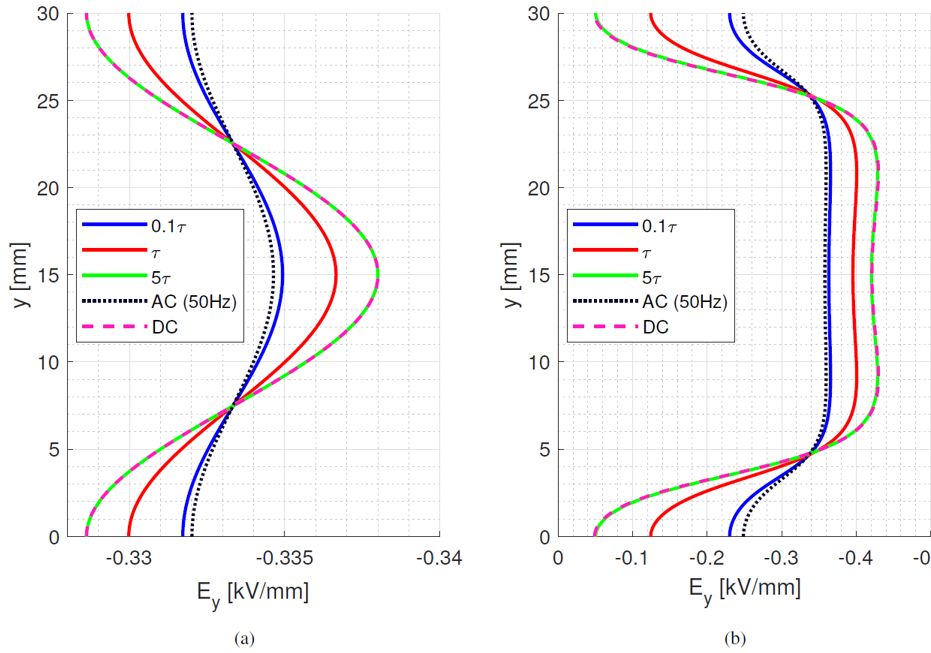
Figure 5. ( a ) bulk orthogonal and ( b ) surface tangential field at different times after voltage step application till steady state dc and sinusoidal ac (50 Hz) for material #1. Time constant τ d = 70 min. Isothermal condition at 25 °C. Test object of Figure 1a.